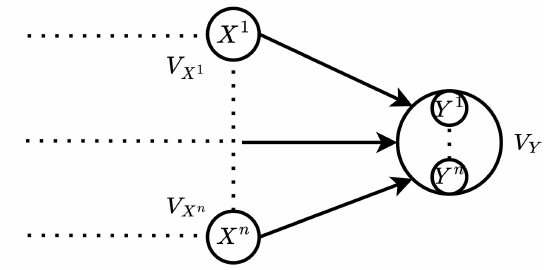
Figure 3. Multi-chain